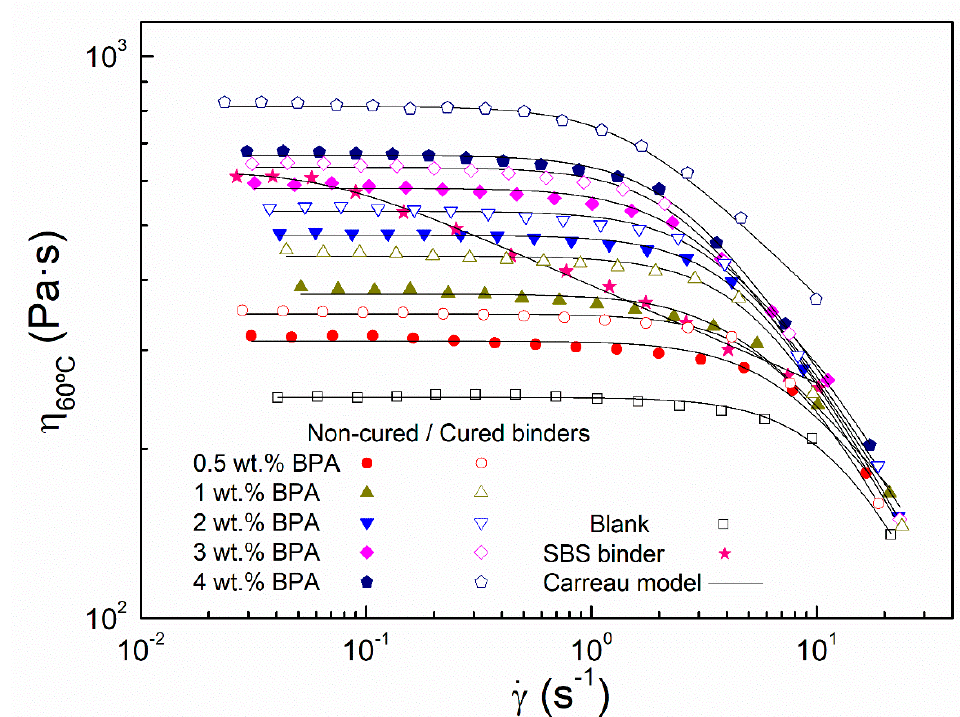
Figure 2. Viscous flow curves at 60 °C for noncured and cured epoxy modified binders. Comparison with a 3 wt % SBS-modified bitumen and neat bitumen subjected to the same mixing conditions (blank sample).